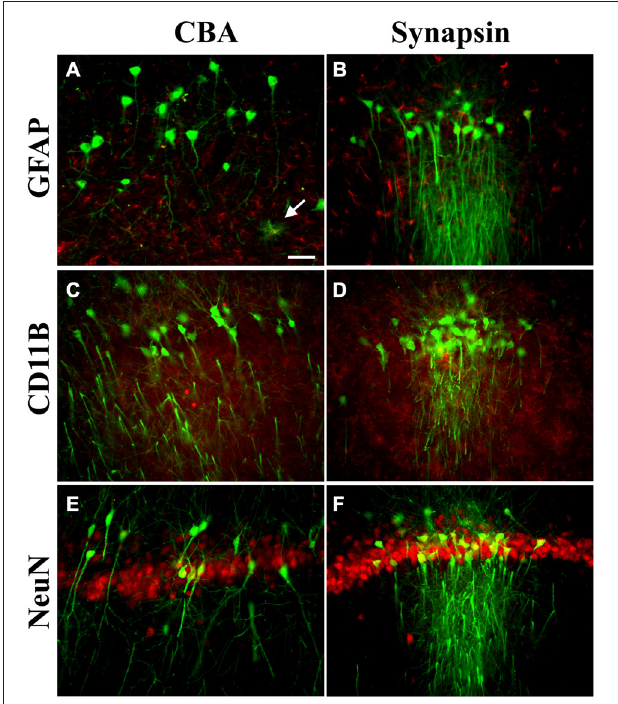
FIGURE 2 | Transgene expression profiles in astroglia, microglia, and neurons in the CNS . Pictures are mergers of GFP immunofluorescence in green and cell type specific markers in red, from the hippocampus. (A,B) For astroglia (glial fibrillary acidic protein, GFAP), there were occasional examples of GFP-positive cells with the cytomegalovirus/chicken beta-actin hybrid (CBA) promoter (arrow) but GFP-positive astroglia were not present using the synapsin promoter. (C,D) For microglia (CD11B), the adeno-associated virus (AAV) transgene did not co-localize with the microglial marker with either promoter. (E,F) Most of the cells expressing the transgene in the CNS were co-labeled with the neuronal marker NeuN with either the CBA or synapsin promoter. AAV-PHP.B was used for both promoters and the expression interval was 4 weeks after intravenous administration. Bar in (A) = 42 µ m, same magnification in (A–F)